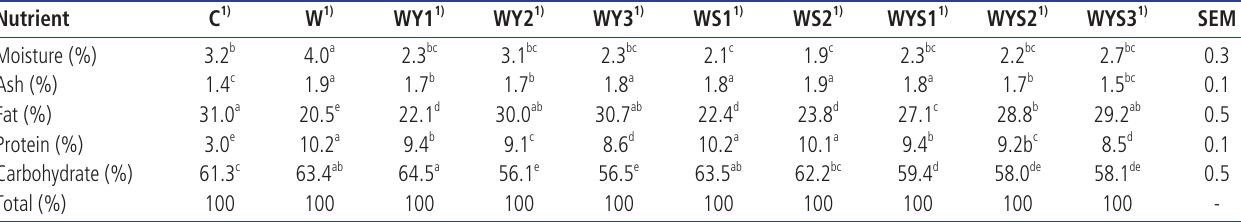
Table 2. The nutrient compositions of non-dairy creamers with different formula Nutrient